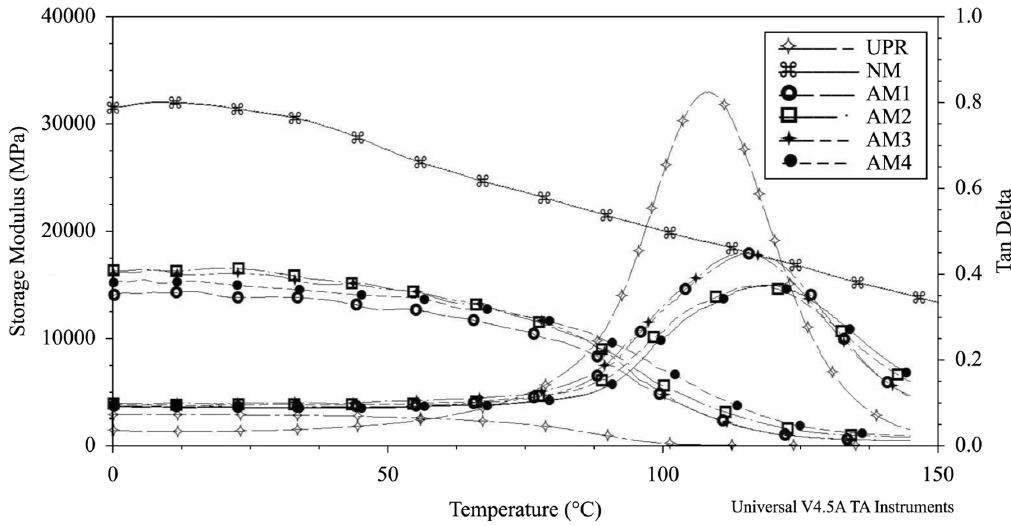
Figure 5. Storage modulus and tangent delta curves for natural marble (NM), unsaturated polyester (UPR), and produced artificial marbles (AM1, AM2, AM3 and